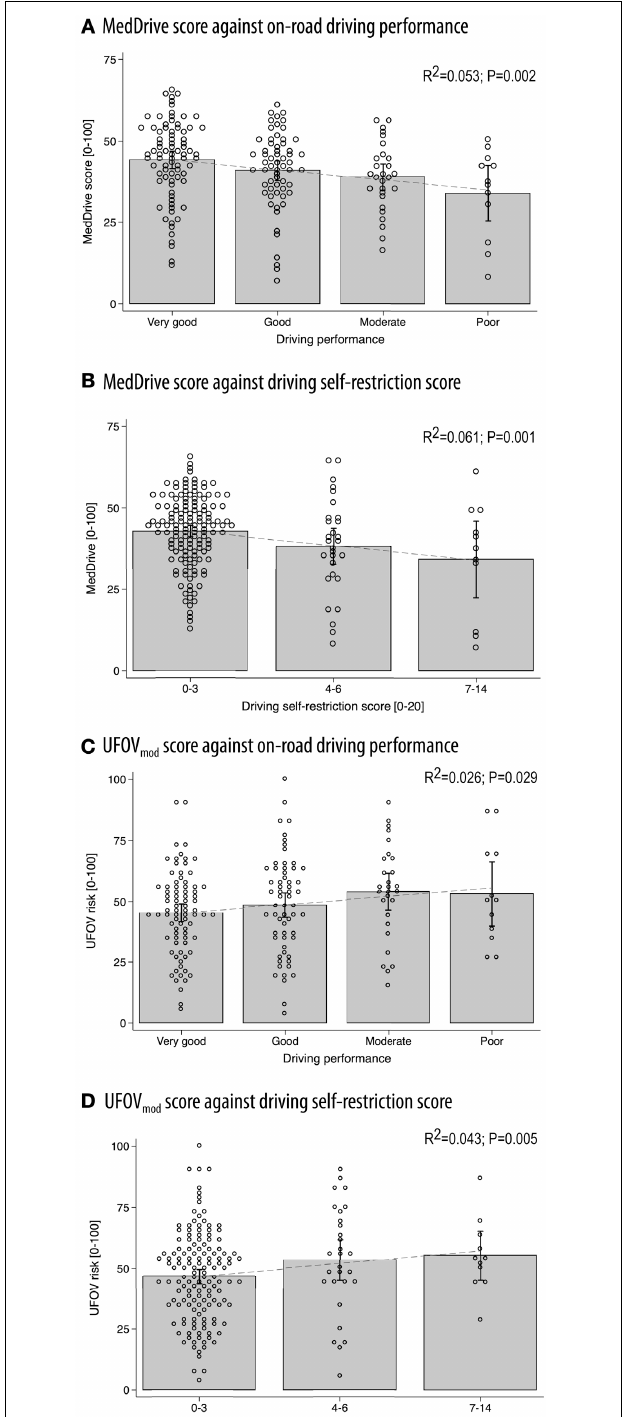
FIGURE 4 | Concurrent validity between MedDrive and the UFOV in predicting on-road driving performance or driving self-restrictions. Correlations between MedDrive and on-road driving performance (A) and driving self-restriction score (B) on 182 older drivers. Concurrent validity was evaluated by providing the UFOV’s correlations to the same measures of driving behavior (C,D) . Dots correspond to each individual observation.